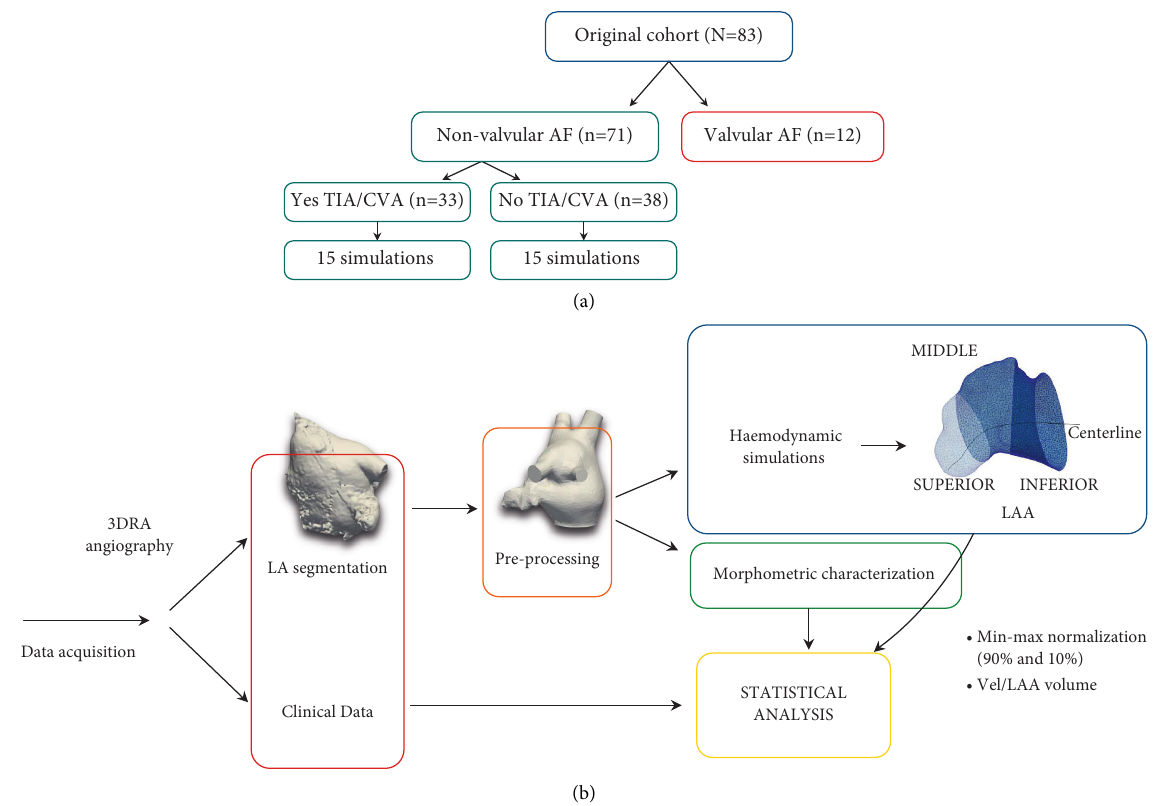
Figure 1: (a) Organization of the cohort of patients with atrial fibrillation (AF), transient ischemic attack (TIA), and cerebrovascular accident (CVA). (b) Computational pipeline followed in the study: data acquisition, left atrium (LA) segmentation from medical images, preprocessing, morphologic characterization of the LA and left atrial appendage (LAA), haemodynamic simulations, postprocessing, and statistical analysis of the